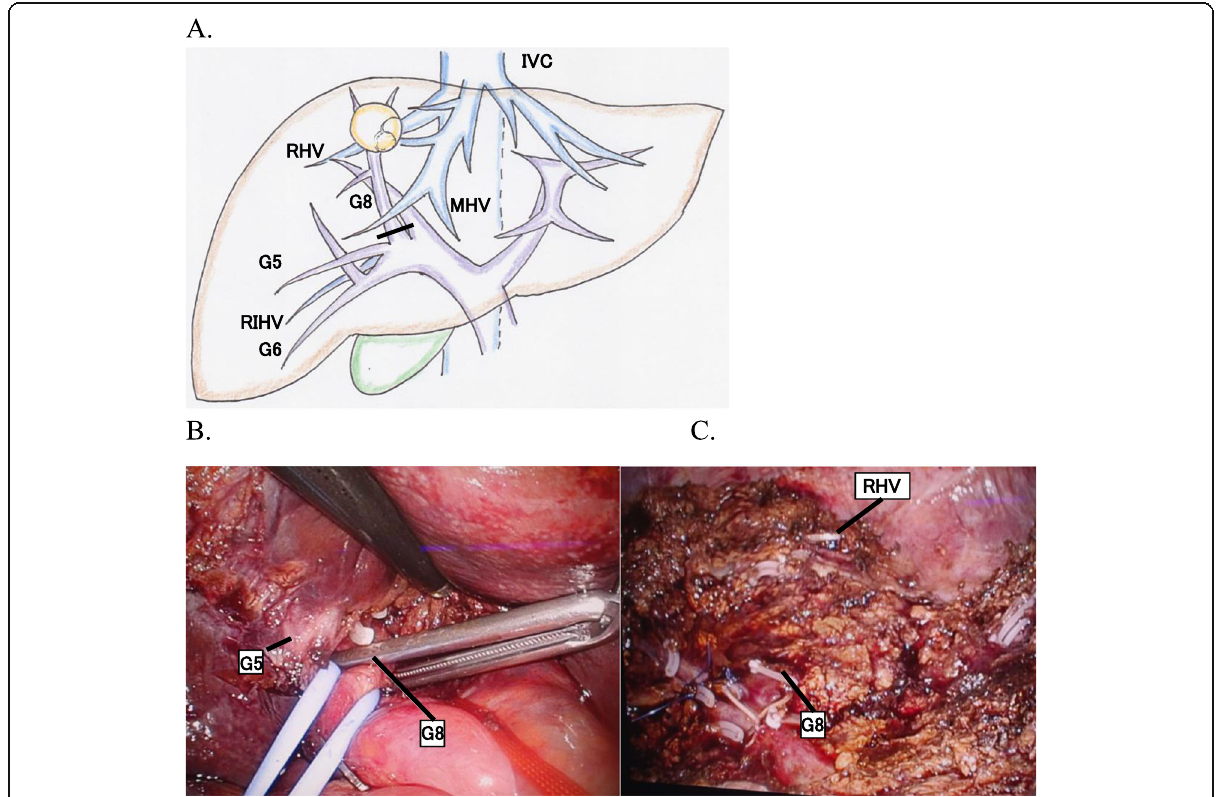
Fig. 3 Anatomical observations and intraoperative findings. a Schema showing anatomy of the liver and the blood vessels. b , c Intraoperative views of the major steps of laparoscopic